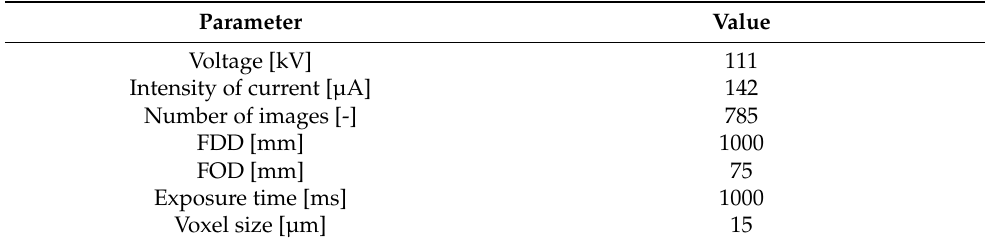
Table 3. CT parameters used for computed